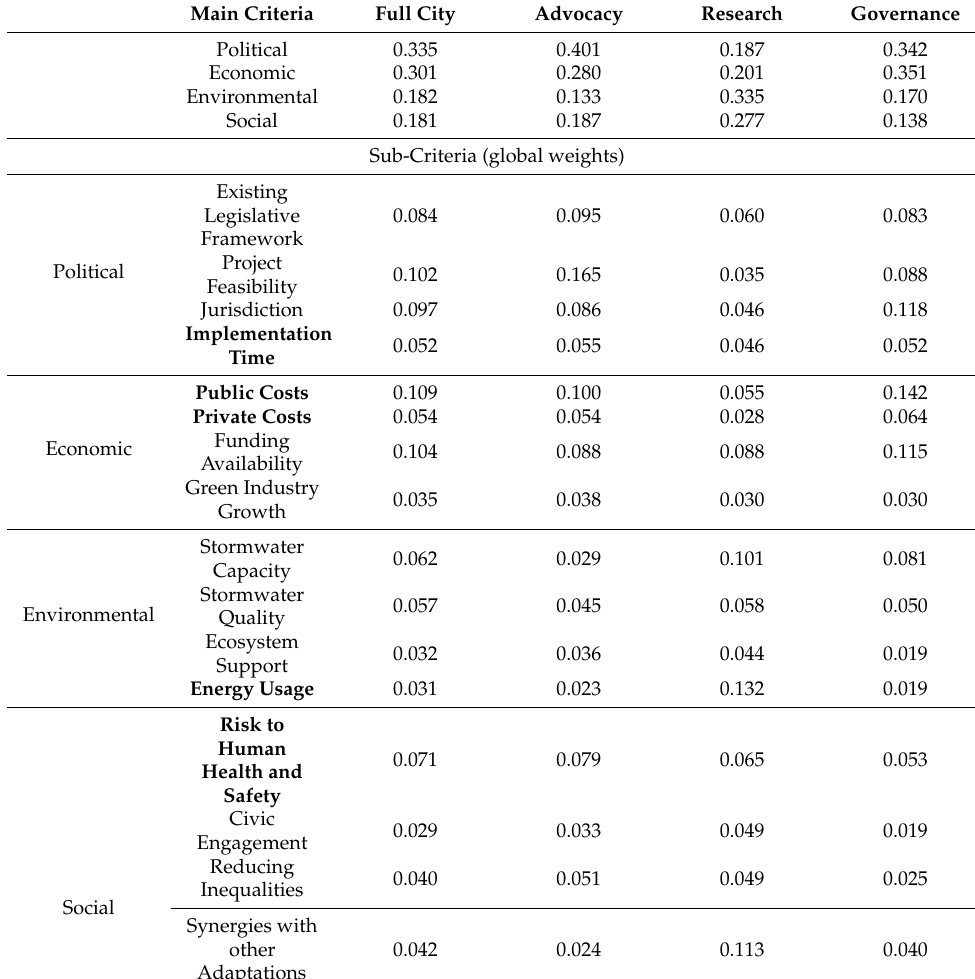
Table 4. The resulting criteria weights of the AHP in New York City stormwater management for the full city and by stakeholder grouping with cost criteria are emphasized in